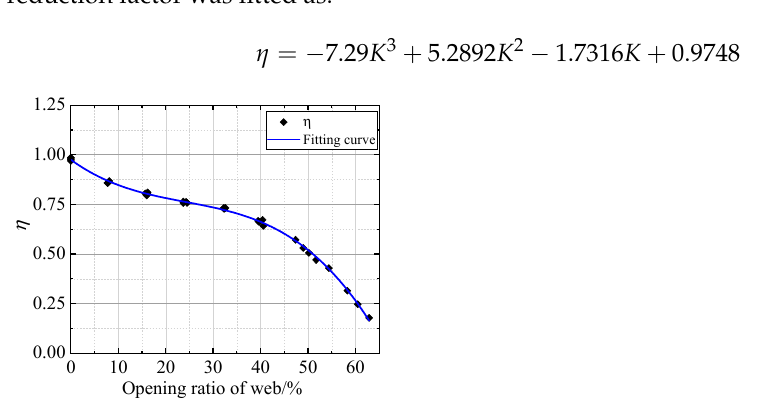
Figure 25. Relationship between reduction factor and opening ratio.